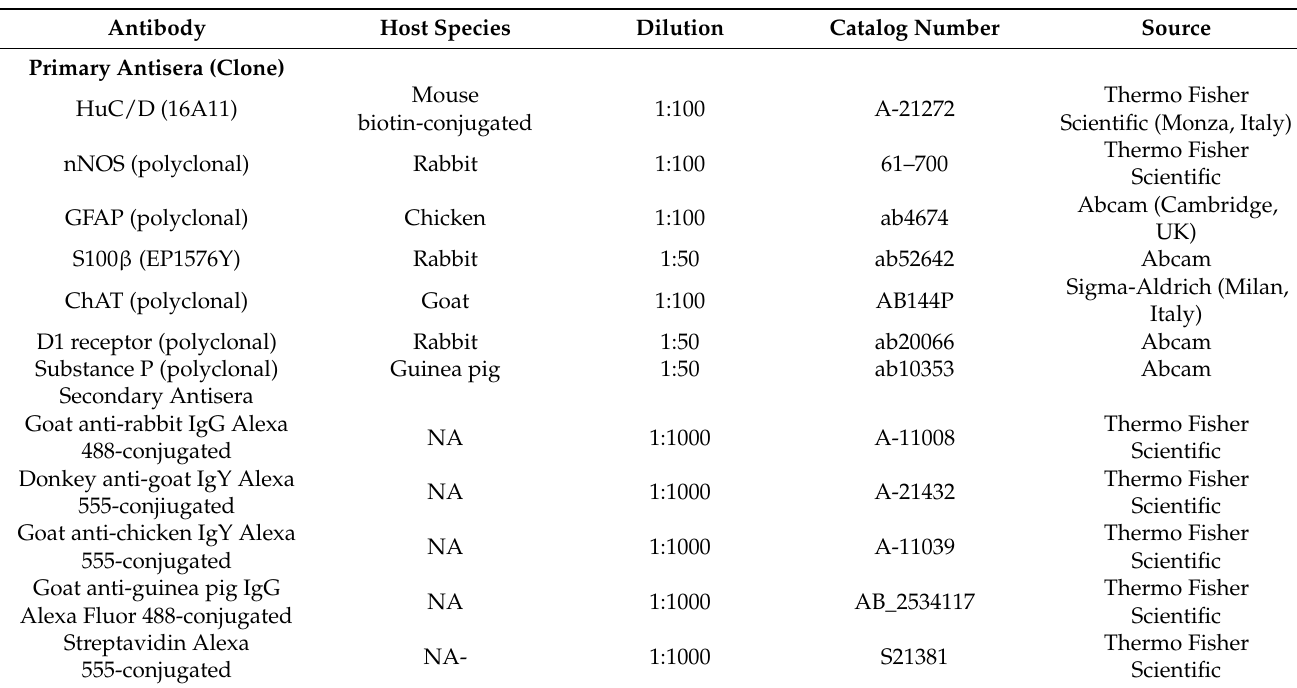
Table 1. Characteristics of primary and secondary antibodies and their respective dilutions used for immunohistochemistry on ileal whole-mount